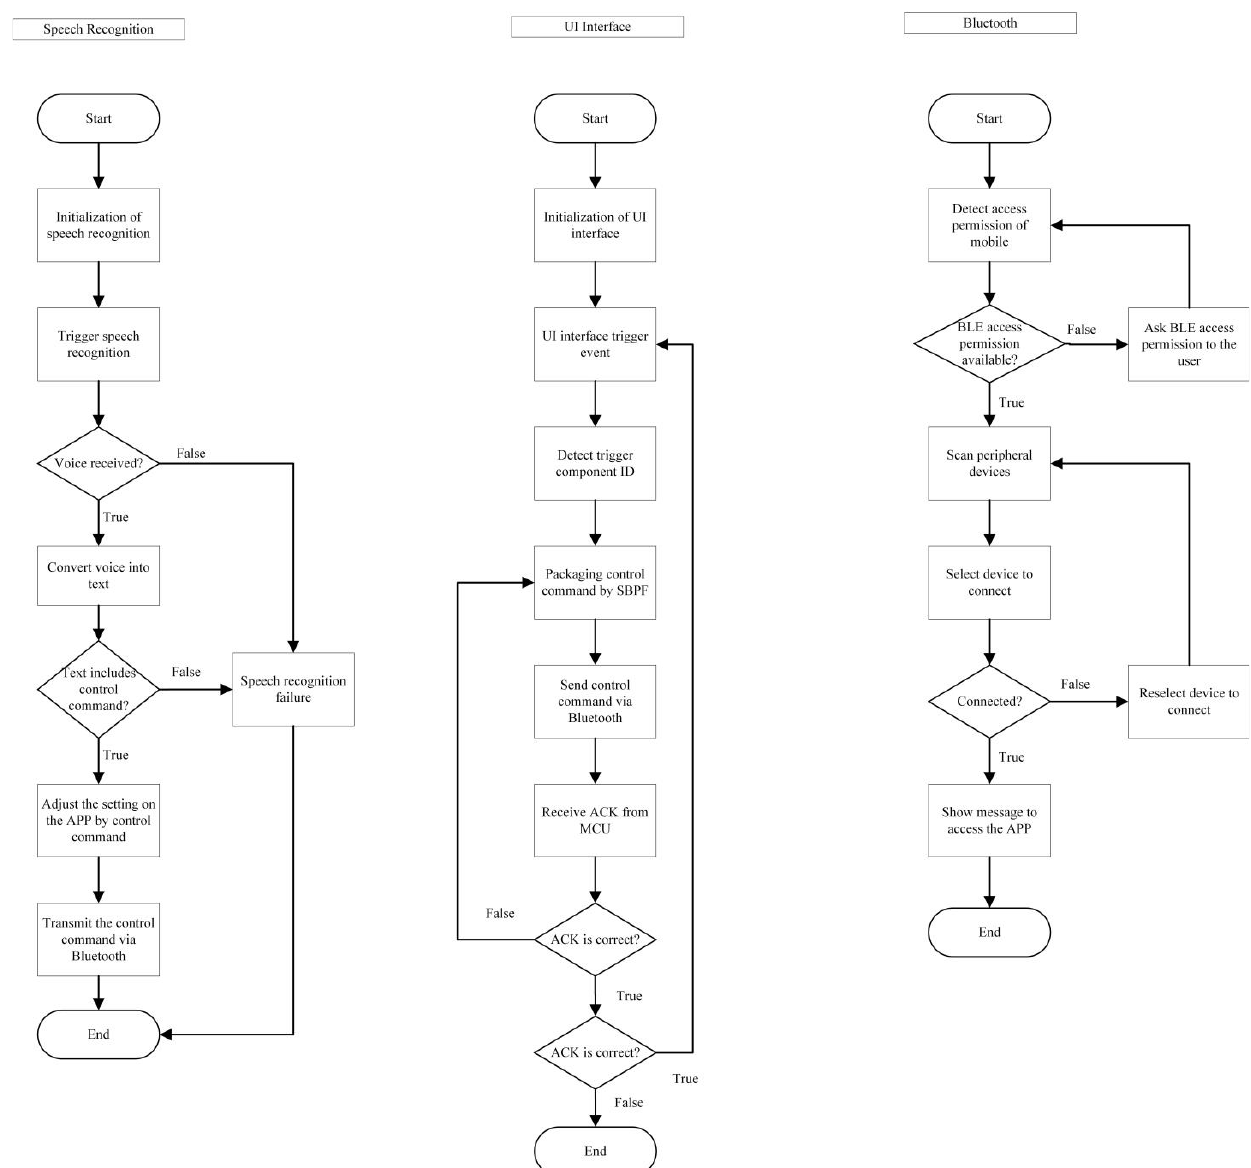
Figure 7. Flowcharts of the proposed smart digital mixer system including speech recognition, UI interface, and Bluetooth.